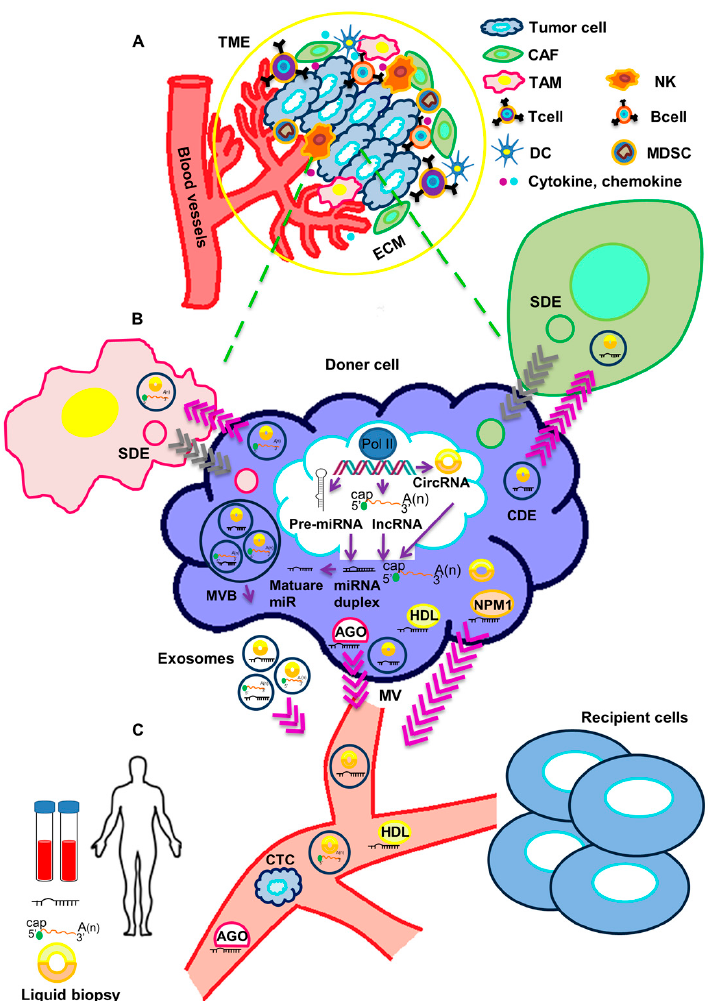
Figure 1. Crosstalk of circulating non-coding RNAs and tumor microenvironment. ( A ) The tumor microenvironment (TME) includes a cellular and an extracellular component. The cellular component consists of tumor cells, immune cells (TAMs, T cells, B cells, NK cells, DCs, and MDSCs) and cancer-associated fibroblasts (CAFs). The extracellular component of TME is composed by ECM proteins and signaling molecules (like cytokines, chemokines, growth factors, hormones, etc.), which are secreted by the cellular component. ( B ) ncRNAs are processed and released in body fluids. Circulating ncRNAs can be released in two ways: (1) as cell-free RNAs, complexed with protein such as AGO, NPM1 or HDL; or (2) in extracellular vesicles (exosomes and microvesicles). Both tumor cells and stromal cells may release exosomes in the TME. Through body fluids, ncRNAs can reach distant sites in the body and act as molecular mediators. ( C ) Circulating ncRNAs are stable and easily detectable and can be used as non-invasive biomarkers in liquid biopsy. TME: tumor microenvironment, TAM: Tumor-associated macrophage, NK: Natural killer cell, DC: Dendritic cell, MDSC: Myeloid-derived suppressor cell, CAF: cancer-associated fibroblast, ECM: extracellular matrix, SDE: Stromal-derived exosome, CDE: Cancer-derived exosome, AGO: Argonaute2, NPM1: Nucleophosmin 1, HDL: High-density lipoprotein, MVB: Multivesicular body, MV: Microvesicle, CTC: Circulating tumor cell.